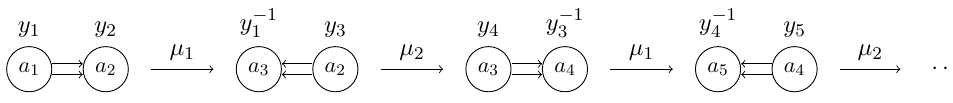
Figure 8 . Cluster sequence M in the a(cid:14)ne rank-2 cluster algebra of A (1)